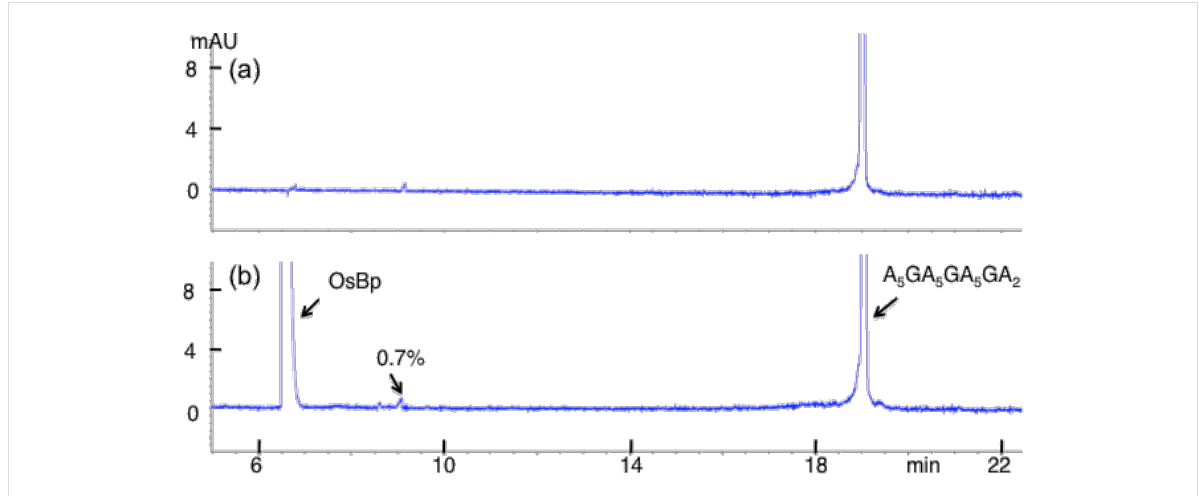
Figure 8: CE profiles of A 5 GA 5 GA 5 GA 2 , a 20-mer with 3 Gs, before and after extensive osmylation to show no detectable reactivity of A and G with OsBp. (a) indicates that this oligo is over 99% pure (b) that the reaction mixture marks the presence of an impurity at 0.7% to show that a reaction product of that level would have been detectable. An osmylation product would have migrated between the oligo and the OsBp peaks (long capillary used here, see Experimental). (a) shows the analysis of the parent oligo at 10 μ M concentration and (b) the analysis of the treated oligo at 20 μ M con- centration.